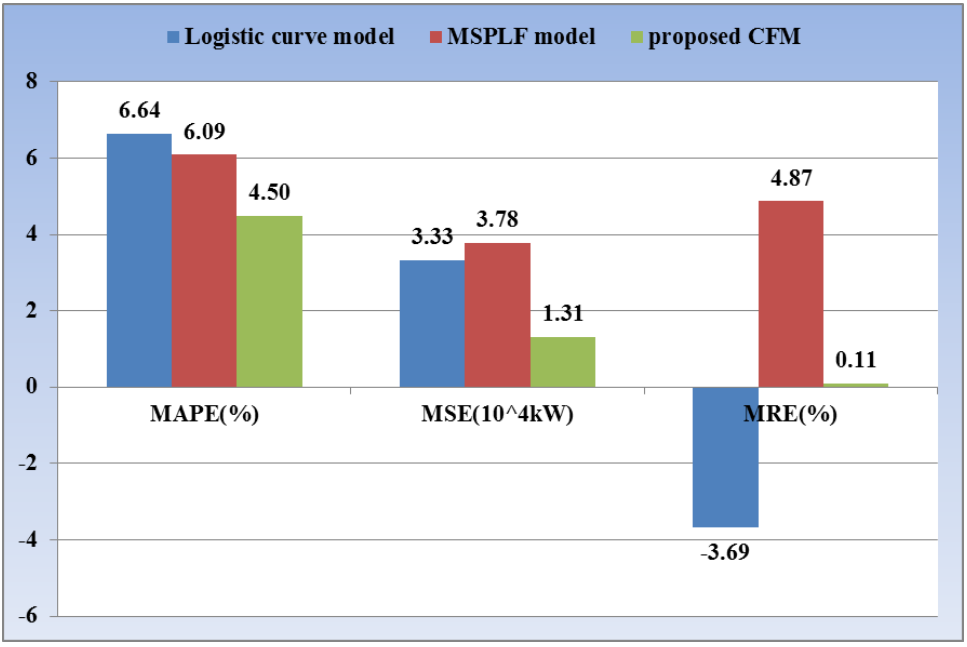
Figure 7. Forecasting error comparisons of different